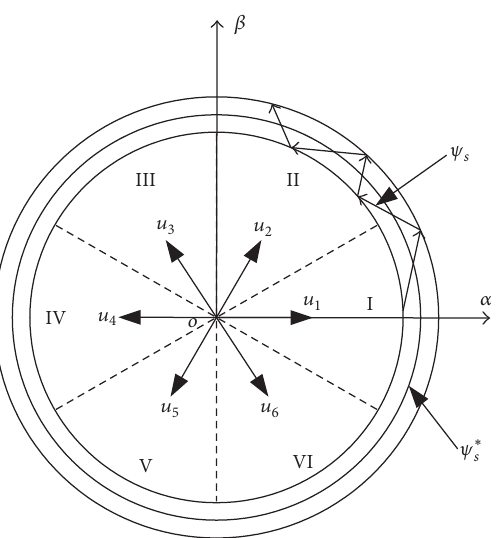
Figure 4: Control principle of DTC